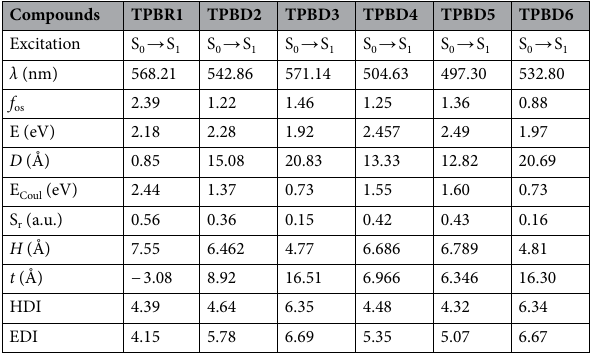
Table 5. Hole-electron analysis indices for S 0 → S 1 excitation (with highest f osc ) of